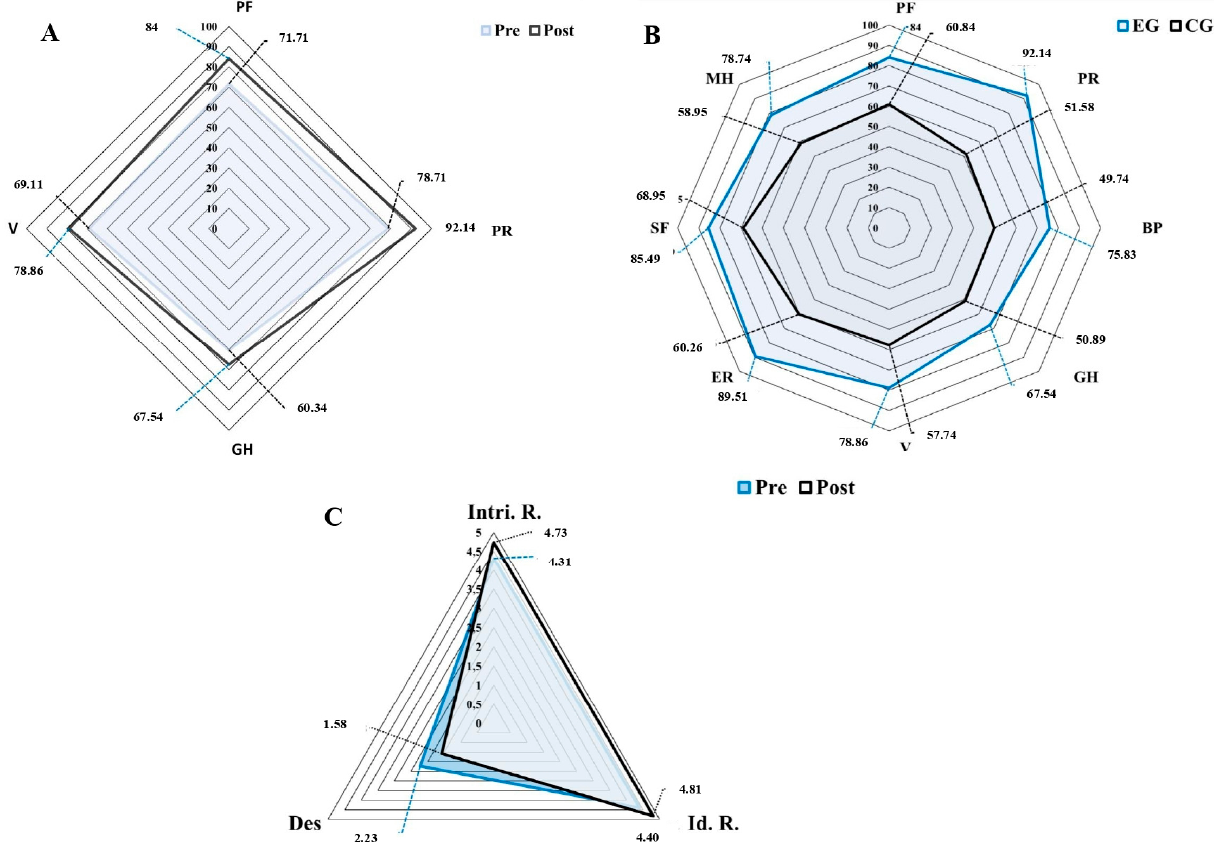
Figure 3. Spider chart accounts for quality of life and motivation to exercise before and after the MPTP in each of the groups. Note: ( A ) EG. Comparison of the mean significant values obtained for the SF-36 health questionnaire before and after the application of the MPTP; ( B ) Comparison between the experimental and control groups after applying the MPTP program in the SF-36 health questionnaire; ( C ) EG. Comparison of the mean significant values obtained for the BREQ-3 Questionnaire before and after the application of the MPTP.